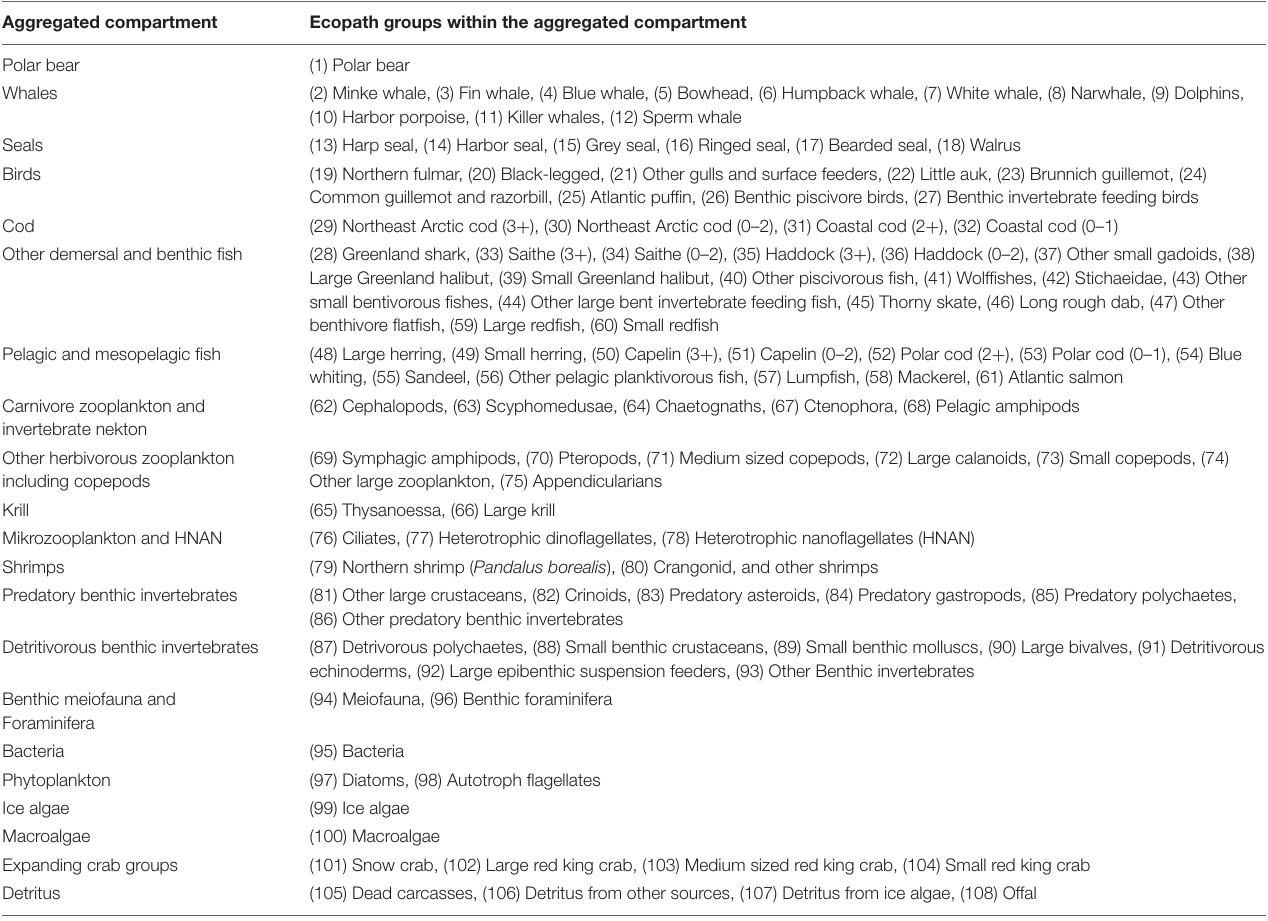
TABLE 1 | Overview of groups for which output values from Ecopath were aggregated into major compartments. Aggregated